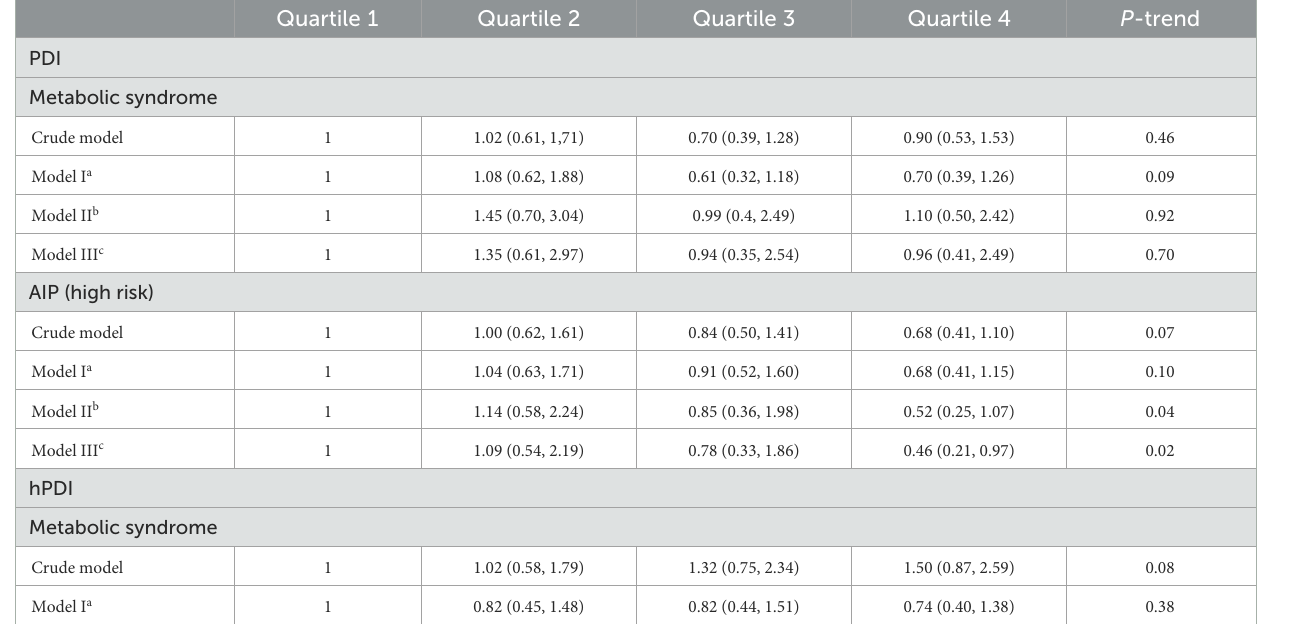
TABLE 2 Multivariate adjusted odds ratio (OR) and 95% confidence interval (CI) for the association of energy-adjusted plant-based diets with metabolic syndrome and high risk AIP. Quartile 1 Quartile 2 Quartile 3 Quartile 4 P